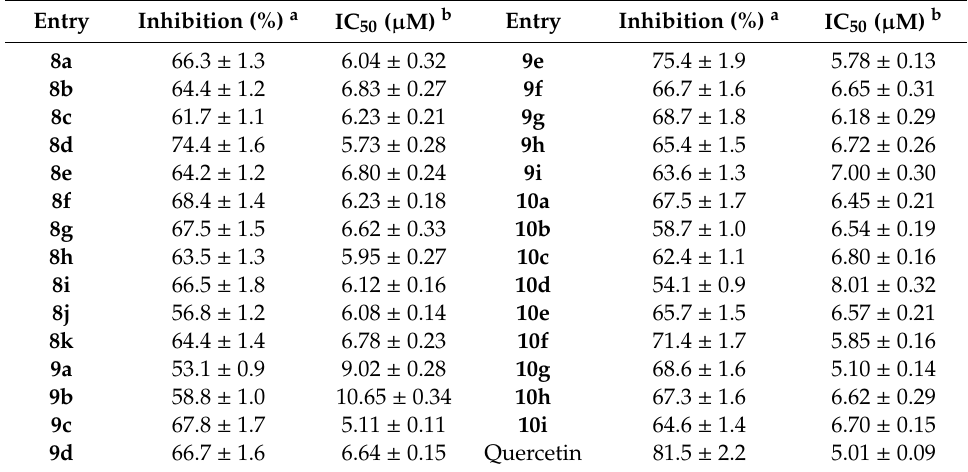
Table 2. Inhibitory e ff ects of the curcumin analogues on bovine lens aldose reductase